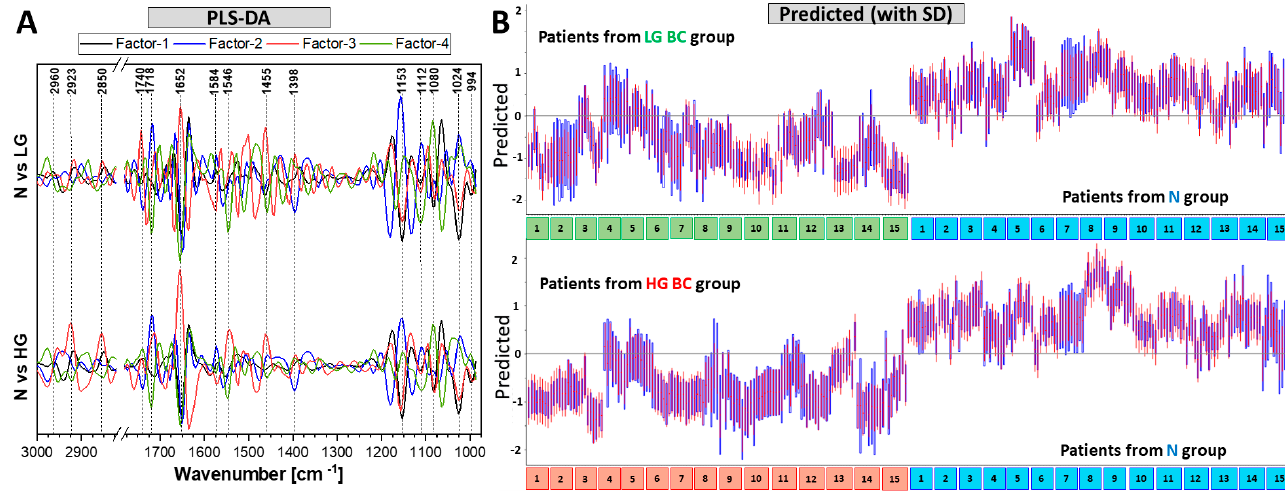
Figure 4. ( A ) PLS-DA loadings (N with positive scores). ( B ) Predicted values, calculated in pairs of N vs. LG BC and N vs. HG BC (red—SD, blue—unexplained by model variance). A total of 135 derivative FTIR spectra from each group (9 spectra from each patient) were taken to build the model, and the remaining 135 spectra were used for prediction. The spectra above zero are predicted as N, and spectra below zero are predicted to be LG or HG BC, respectively.